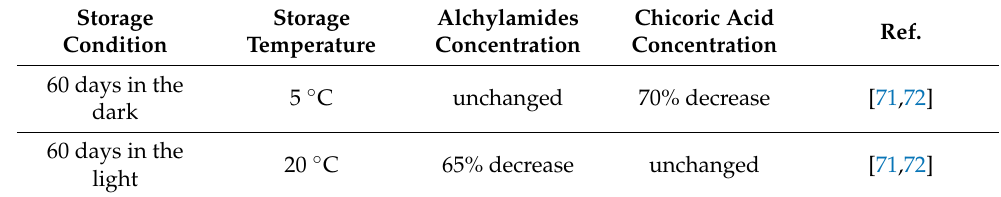
Table 1. Correlation between the storage condition and bioactive compounds concentration.